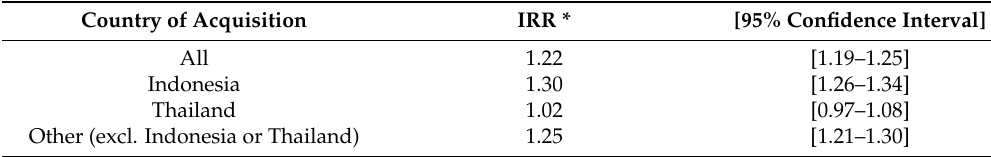
Table 1. Change in dengue notification incidence per year, Victoria